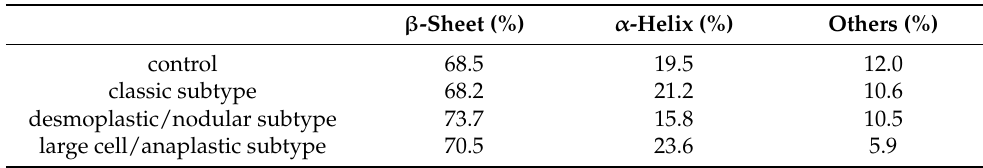
Table 3. Percentage composition of secondary structure in each histological subtype, according to relative area of component bands.